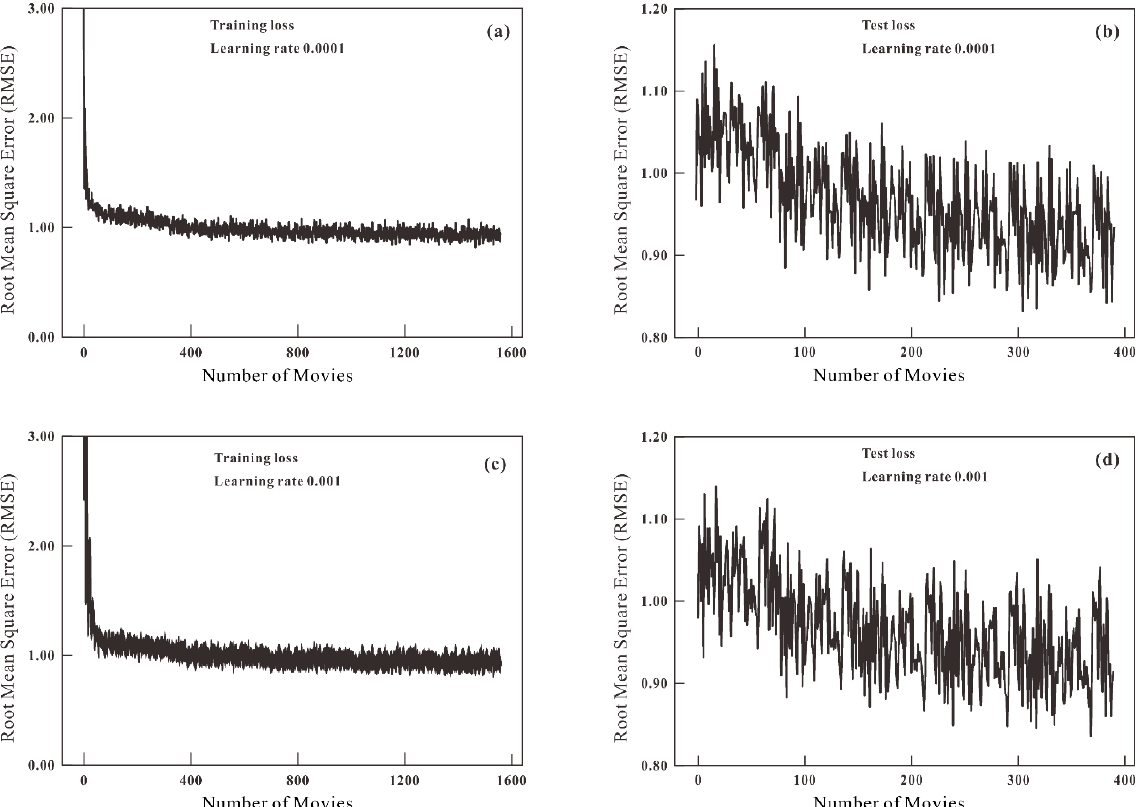
Figure 6. The RMSE scores of the training set ( a , c ) and test set ( b , d ) vs. number of movies for the multimodal recommendation systems using deep-learning algorithm with movie posters based on the MovieLens 100 K dataset.